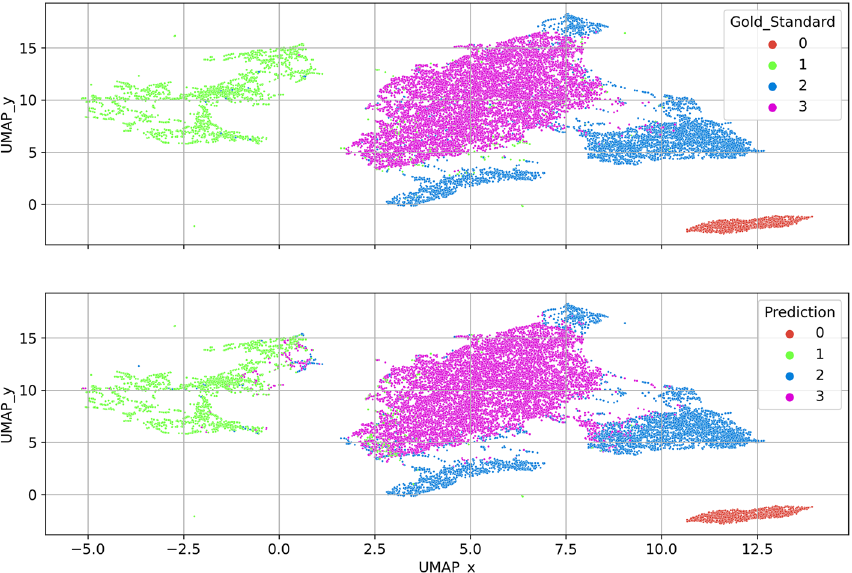
Figure 7. A representative example of uniform manifold approximation and projection (UMAP) of autoencoder embeddings from the testing set. The top picture depicts gold-standard data projections, and the bottom picture depicts predictions of the model. The shown model used 700 annotated examples in each classification category for training and achieved an F1-score of 0.91 evaluated on the out-of-sample test set. The classes are ordered as follows: 0-Power line noise, 1-Artifacts, 2-Pathological Activity, 3-Physiological Activity.